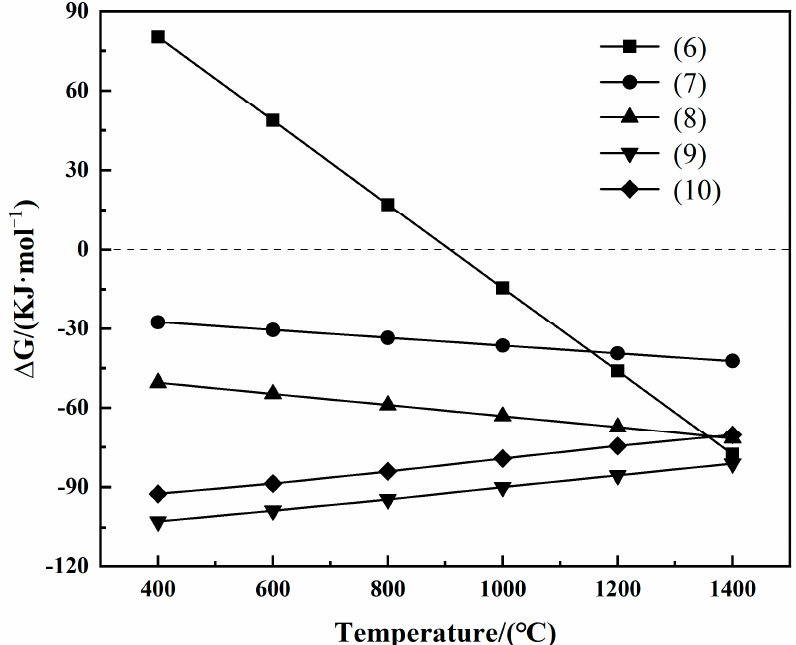
Figure 6. Correlation between the standard Gibbs free energy ( Δ G θ ) and temperature for reactions (6) – (10) in Table 3. Table 3. Possible chemical reactions during the sintering process of red mud.